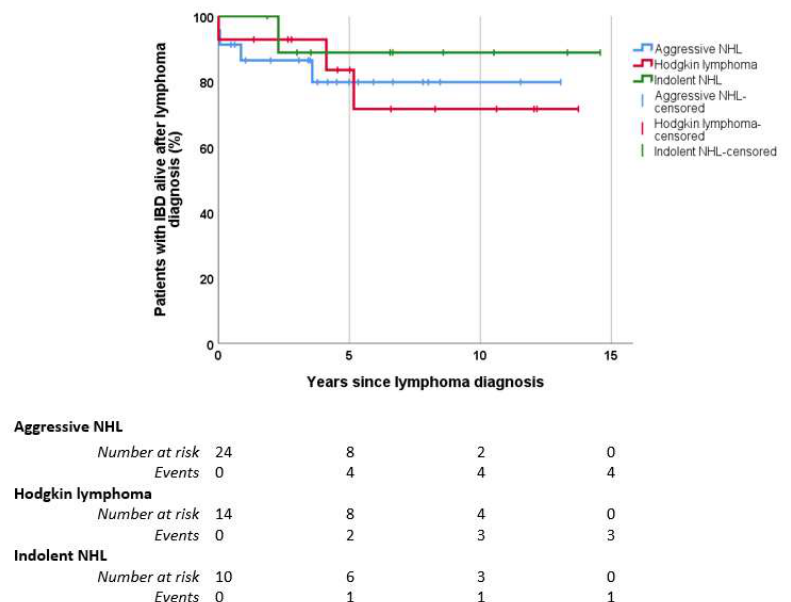
Figure 1. Survival Kaplan–Meier curve of patients with IBD after lymphoma diagnosis. IBD: inflammatory bowel disease. NHL: non-Hodgkin lymphoma. Aggressive NHL: diffuse large B-cell lymphoma, mantle cell lymphoma, plasmablastic lymphoma, and cutaneous lymphoma. Indolent NHL: follicular, marginal zone, and lymphoplasmacytic lymphoma. Five-year survival rate: 80% aggressive NHL, 84% Hodgkin lymphoma, 89% indolent NHL. Ten-year survival rate: 80% aggressive NHL, 72% Hodgkin lymphoma, 89% indolent NHL. Log-rank p > 0.05.